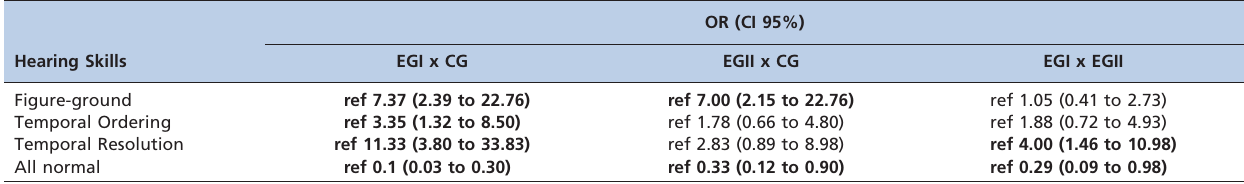
Table 5 - Statistical analysis comparing student performance based on hearing skills.